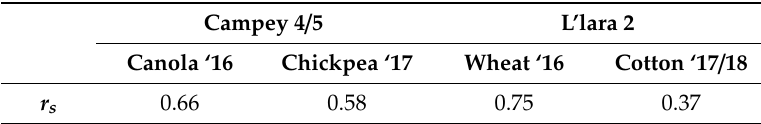
Figure 9. ( a ) Boxplots of the relationship of crop yield data with the predicted depth-to-high soil pH constraint data for field Campey 4/5. ( b ) Boxplots of the relationship of crop yield data with the predicted depth-to-high soil pH constraint data for field L’lara 2. Table 4. The Spearman’s correlation ( r s ) of the relationship between the depth-to-soil pH constraint map data and the median yield value for each 1-cm depth increment to 100 cm.